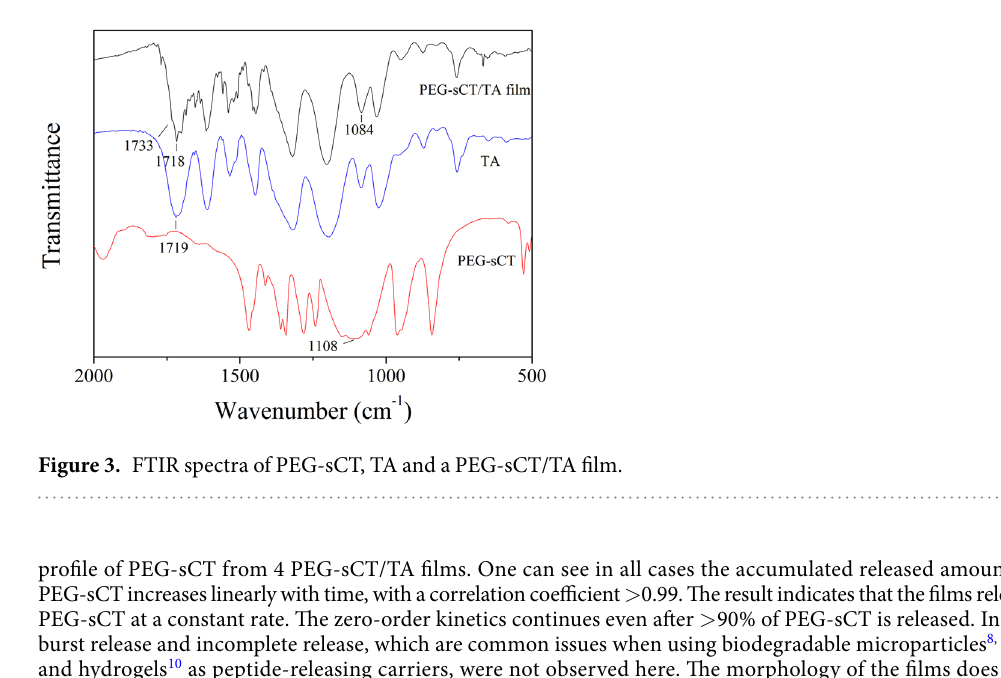
Figure 2. UV-vis absorption spectra of PEG-sCT/TA films with various bilayer numbers (0–15). Inset: Plot of absorbance at 216 and 278 nm against the bilayer number. Both bands can be assigned to phenyl groups in TA.